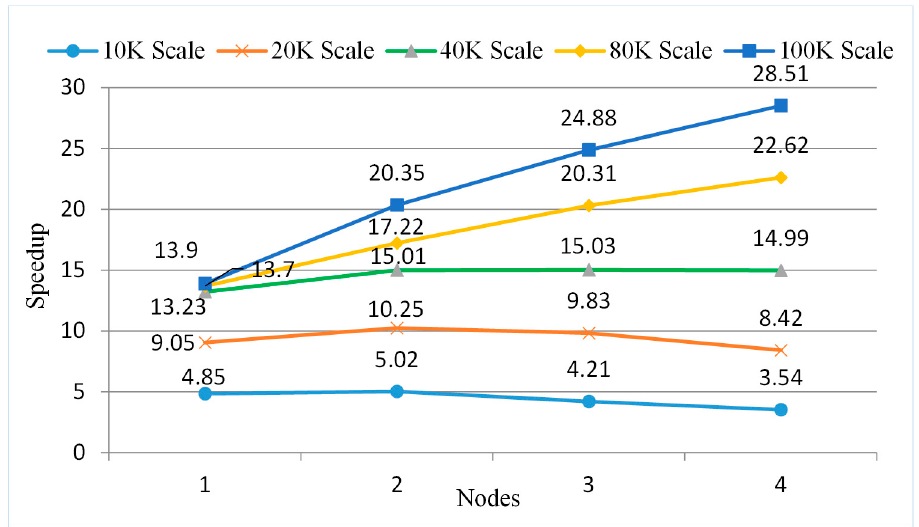
Figure 20. Achieved speedup of the parallel algorithm with different data scales with the Yarn resources manger.